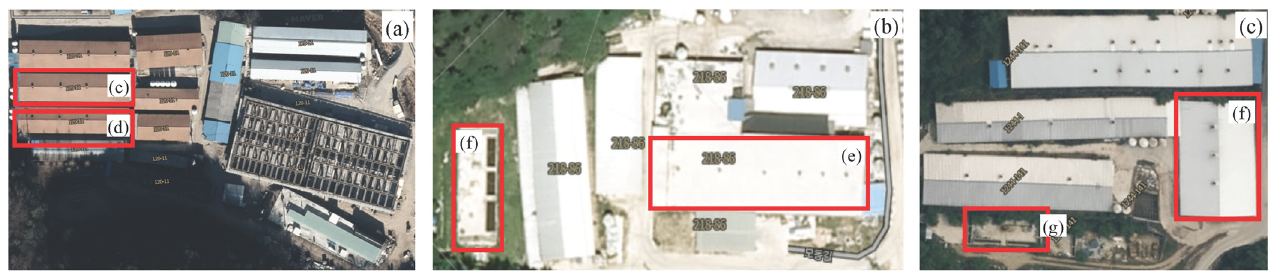
Figure 1. Pictures of experimental farms. (a) a common farm not equipped with continuous pit recirculation system (Farm A, control); (b) Farm B; and (c) Farm C. (d) and (e) two rooms of a finishing pig confinement building in a farm not equipped with continuous pit recirculation system; (f) and (g) two room of a finishing pig confinement building in the farm equipped with continuous pit recirculation system; (h) and (i) air-treated liquid manure manufacturing facility.